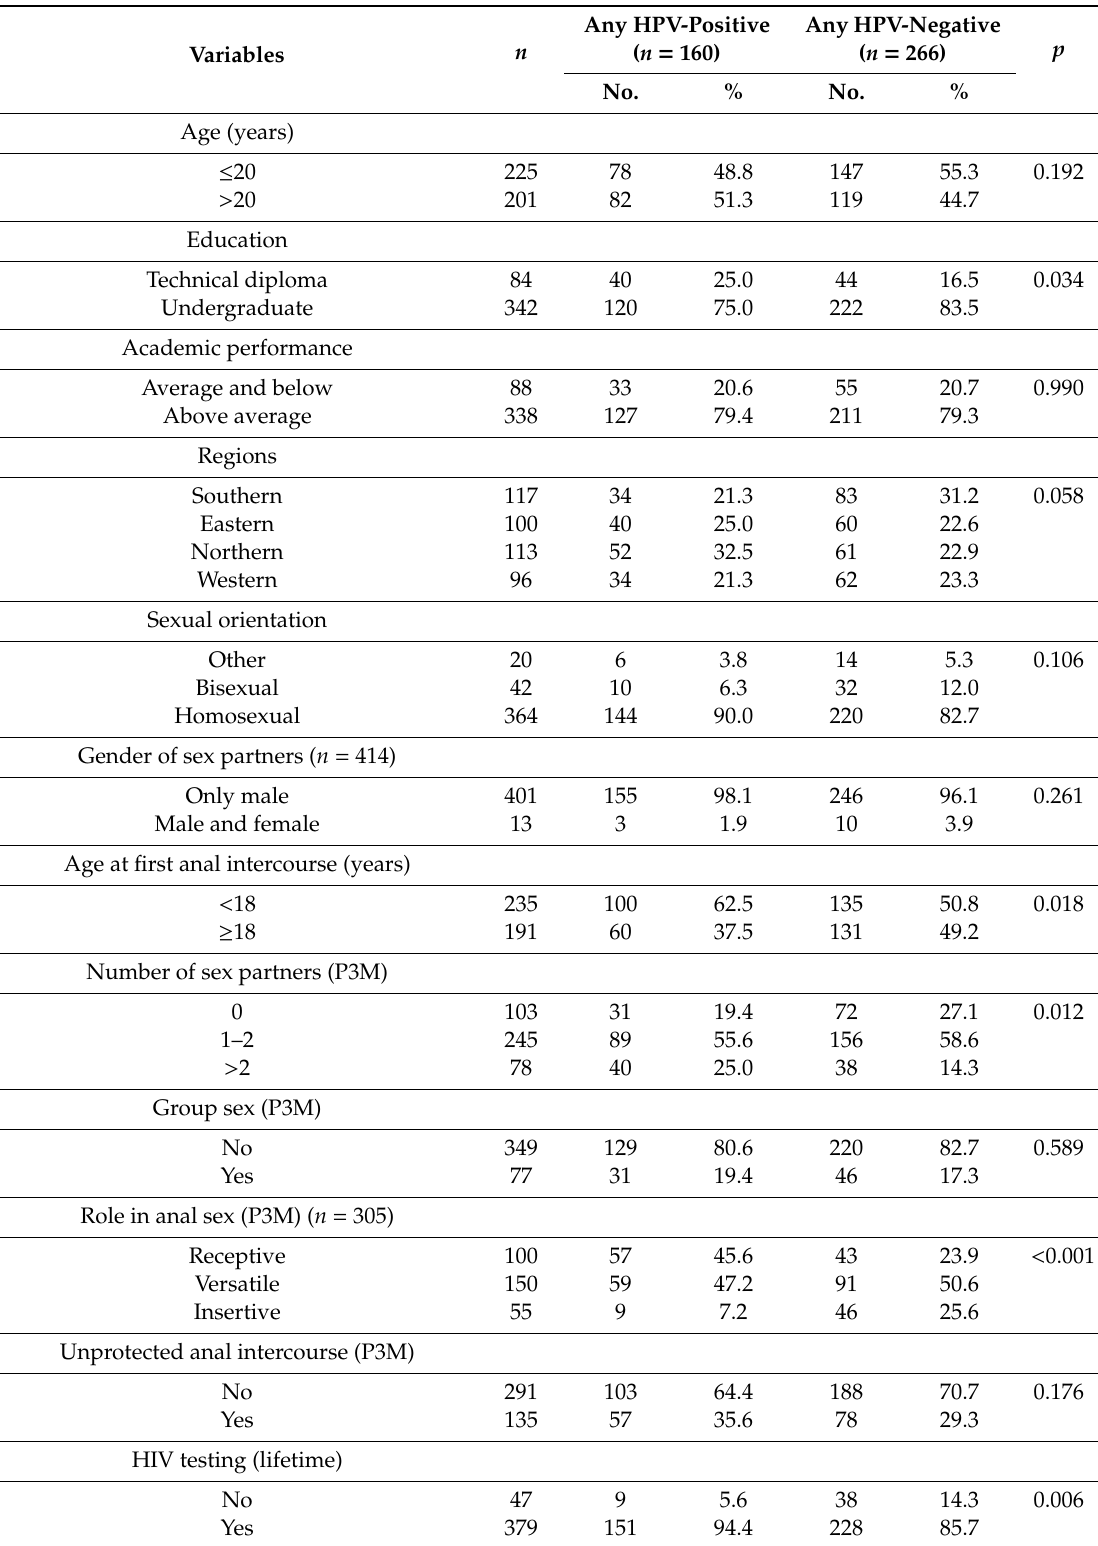
Table 1. Demographic characteristics and sexual behaviors among MSM attending university in China ( n = 426).